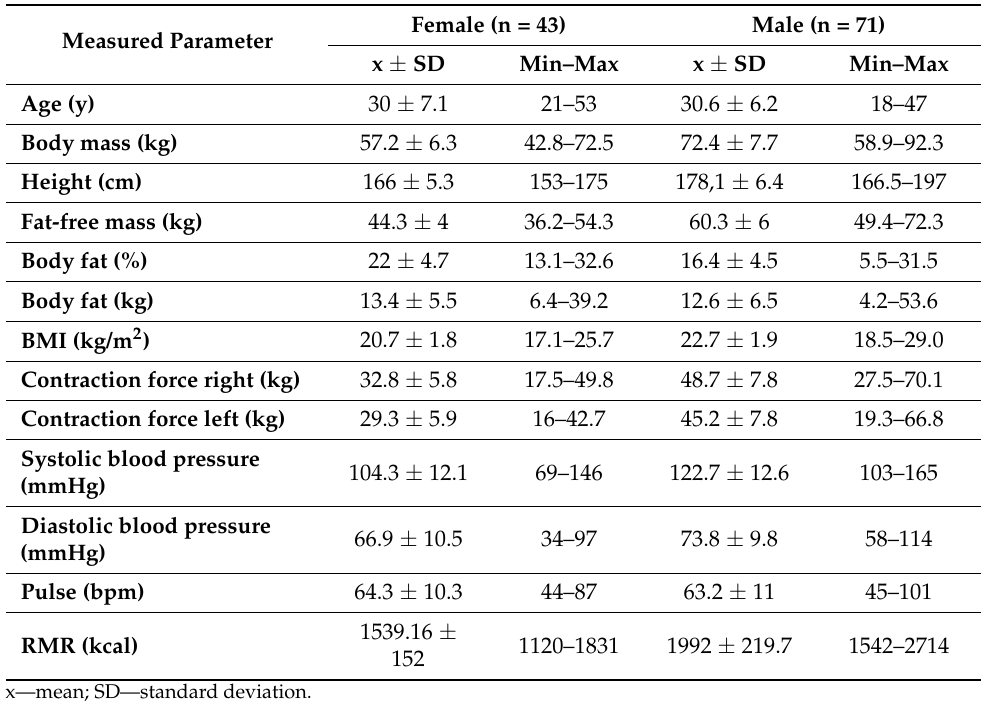
Table 2. Characteristics of the study group.